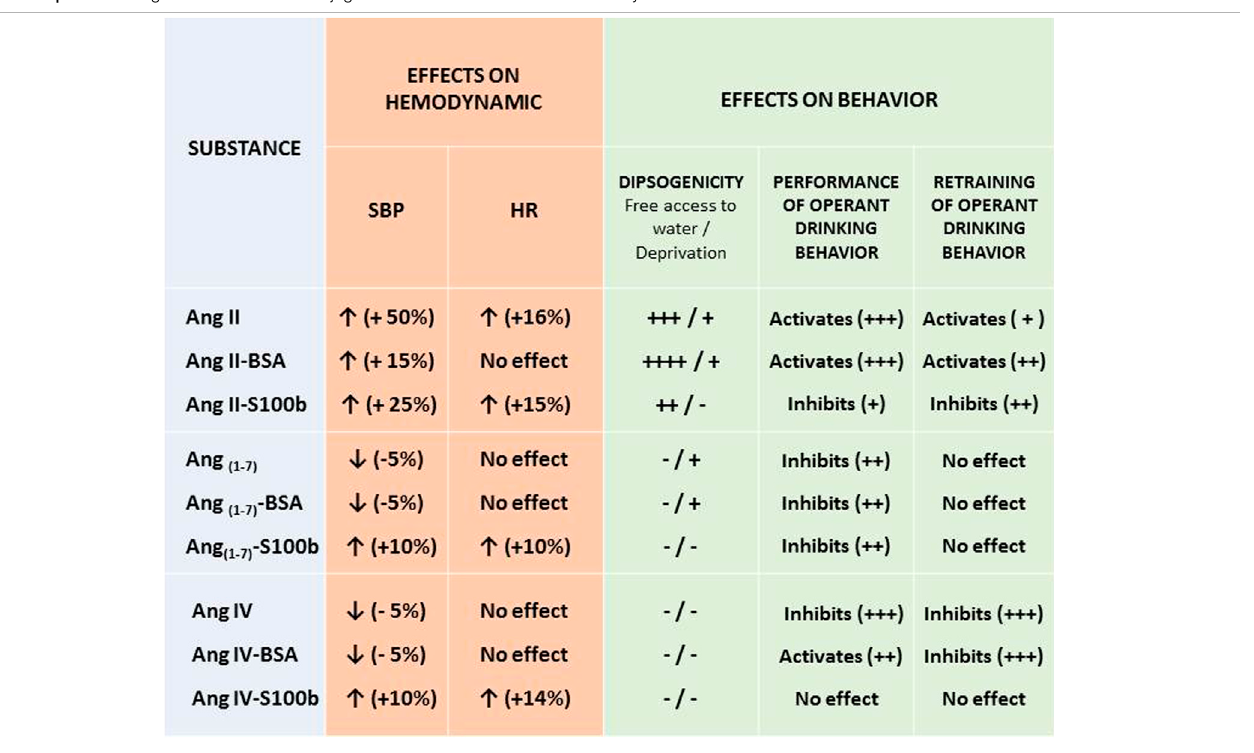
TABLE 1 | Effect of angiotensins and their conjugates with BSA and S100b on hemodynamics and